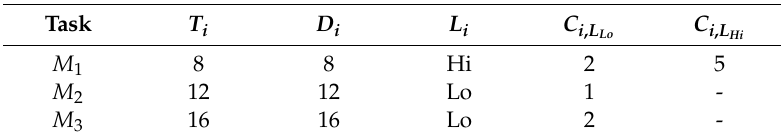
Table 6. Task set Table 6. Task set example.